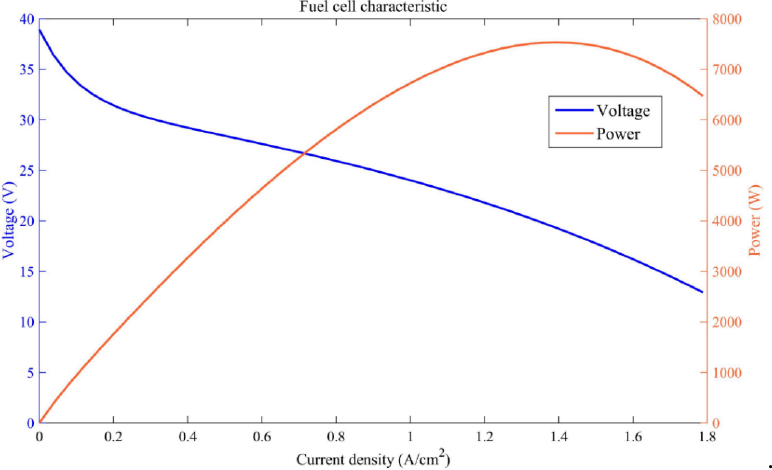
Figure 2. The voltage and power of fuel cell stack.